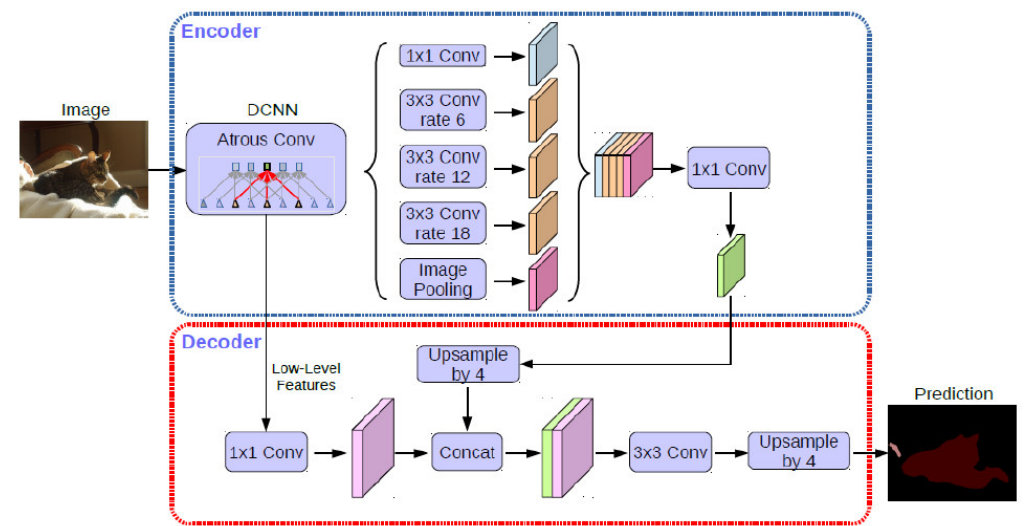
Figure 6. General ResNet Atrous